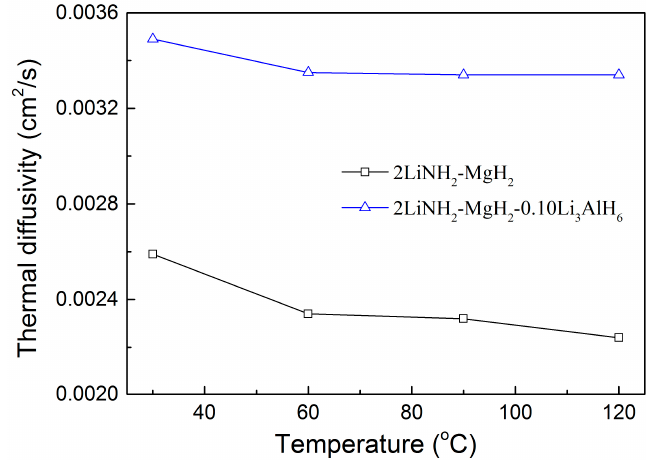
Figure 3. Thermal diffusivity for 2LiNH 2 -MgH 2 and 2LiNH 2 -MgH 2 -0.1Li 3 AlH 6 samples at different temperatures.